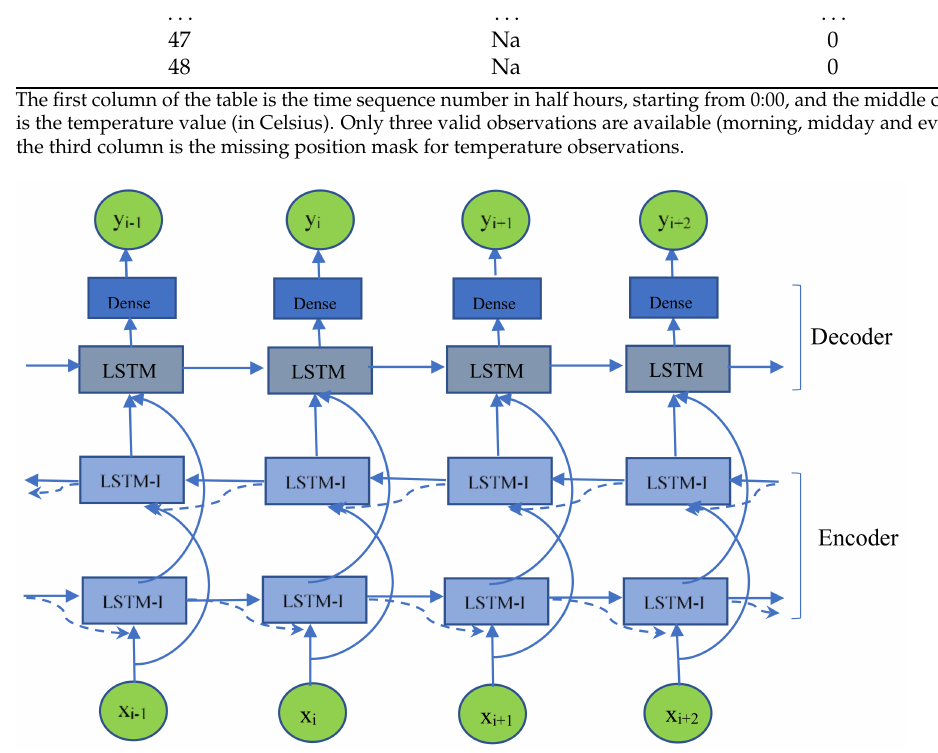
Figure 2. Structure of the imputation neural network for missing temperature